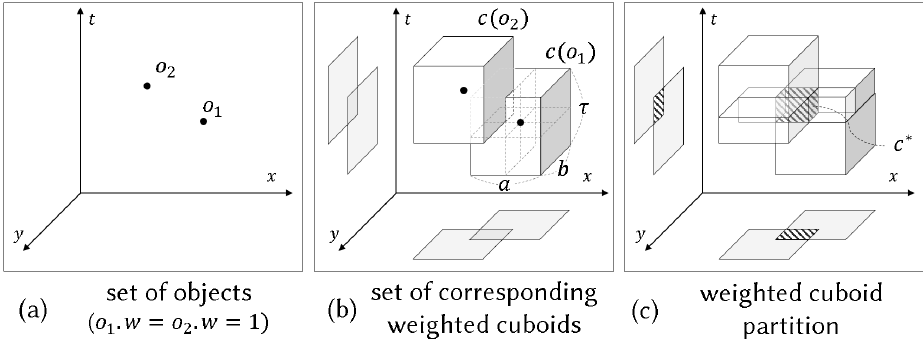
Figure 2. An example of the set of weighted cuboids and a weighted cuboid